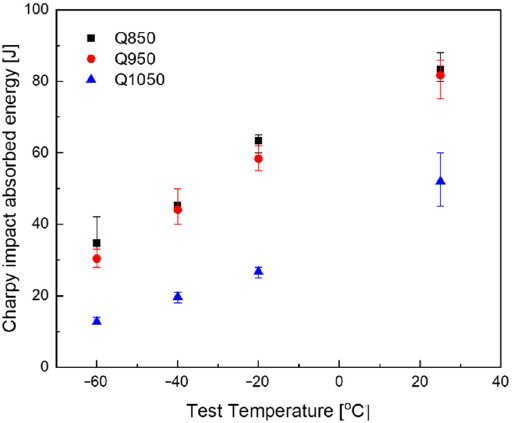
Figure 6. Charpy impact energy of experimental samples: ( a ) Q850, ( b ) Q950 and ( c ) Q1050.